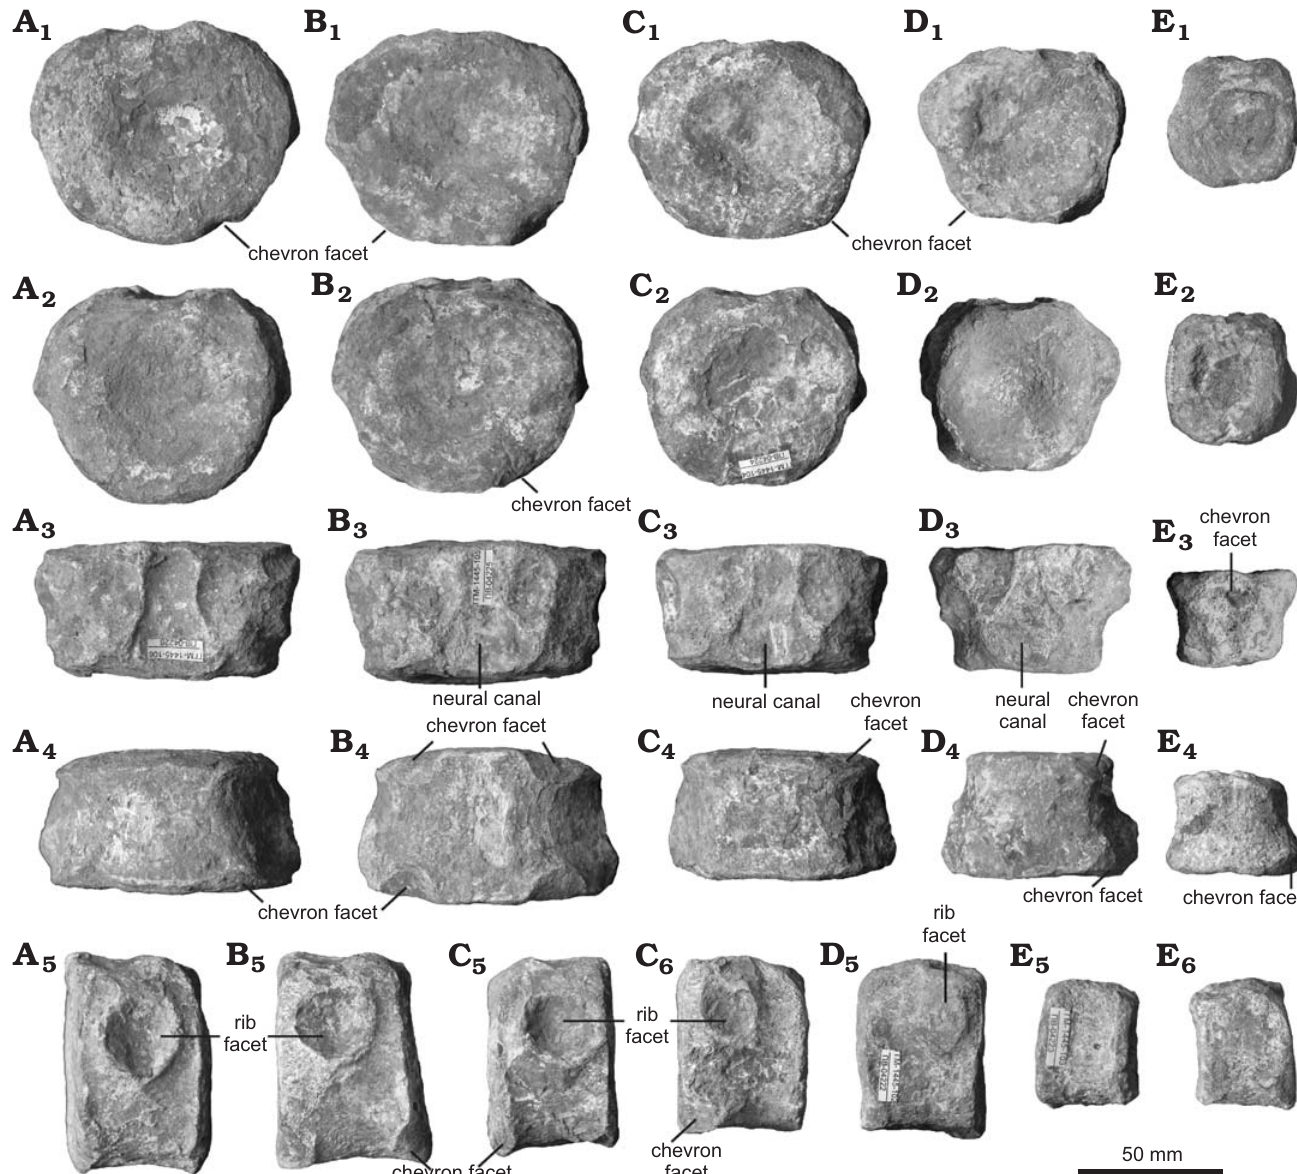
Fig. 5. Caudal centra of the plesiosaur Rhomaleosauridae indet. from the Lower Callovian Hlebnovka Formation of “Konnyi barak” ravine, Russia. SGM 1445-106 ( A ), SGM 1445-105 ( B ), SGM 1445-104 ( C ), SGM 1445-102 ( D ), and SGM 1445-103 ( E ), in anterior (A